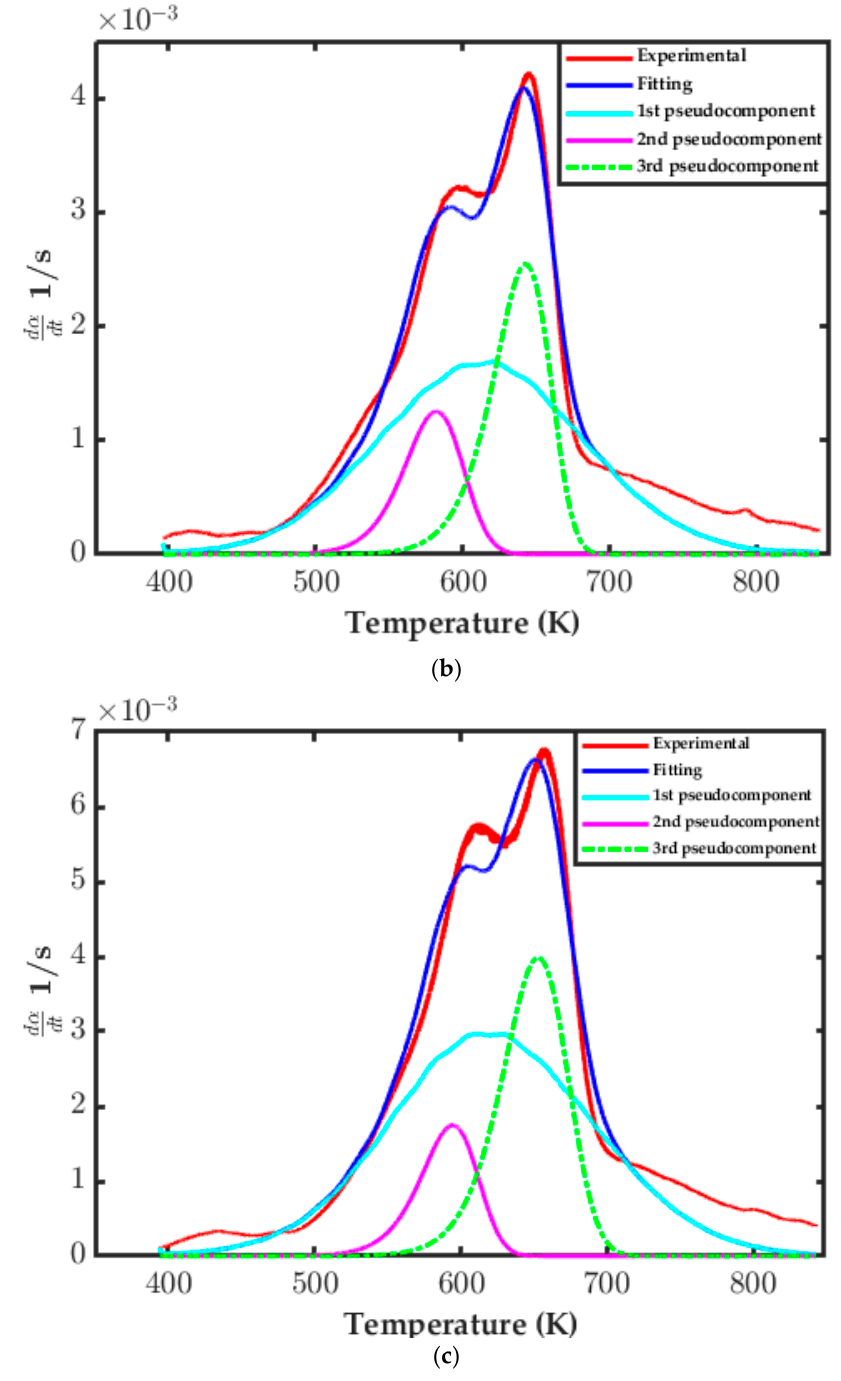
Figure 4. DAEM model fitting for: ( a ) EFB + 1% Zn at 10 K/min; ( b ) EFB + 1% Zn at 30 K/min; ( c ) EFB + 1% Zn at 50 K/min.